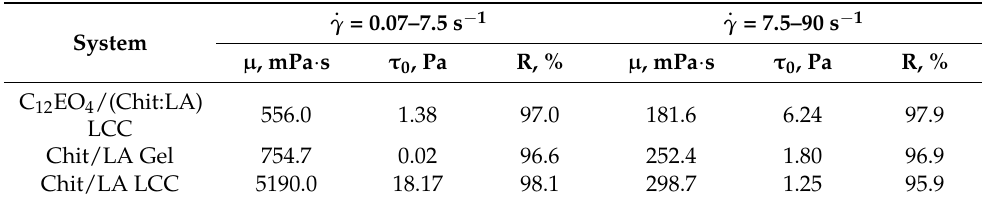
Table 1. Rheological characteristics of the systems at smaller shear rates (Casson